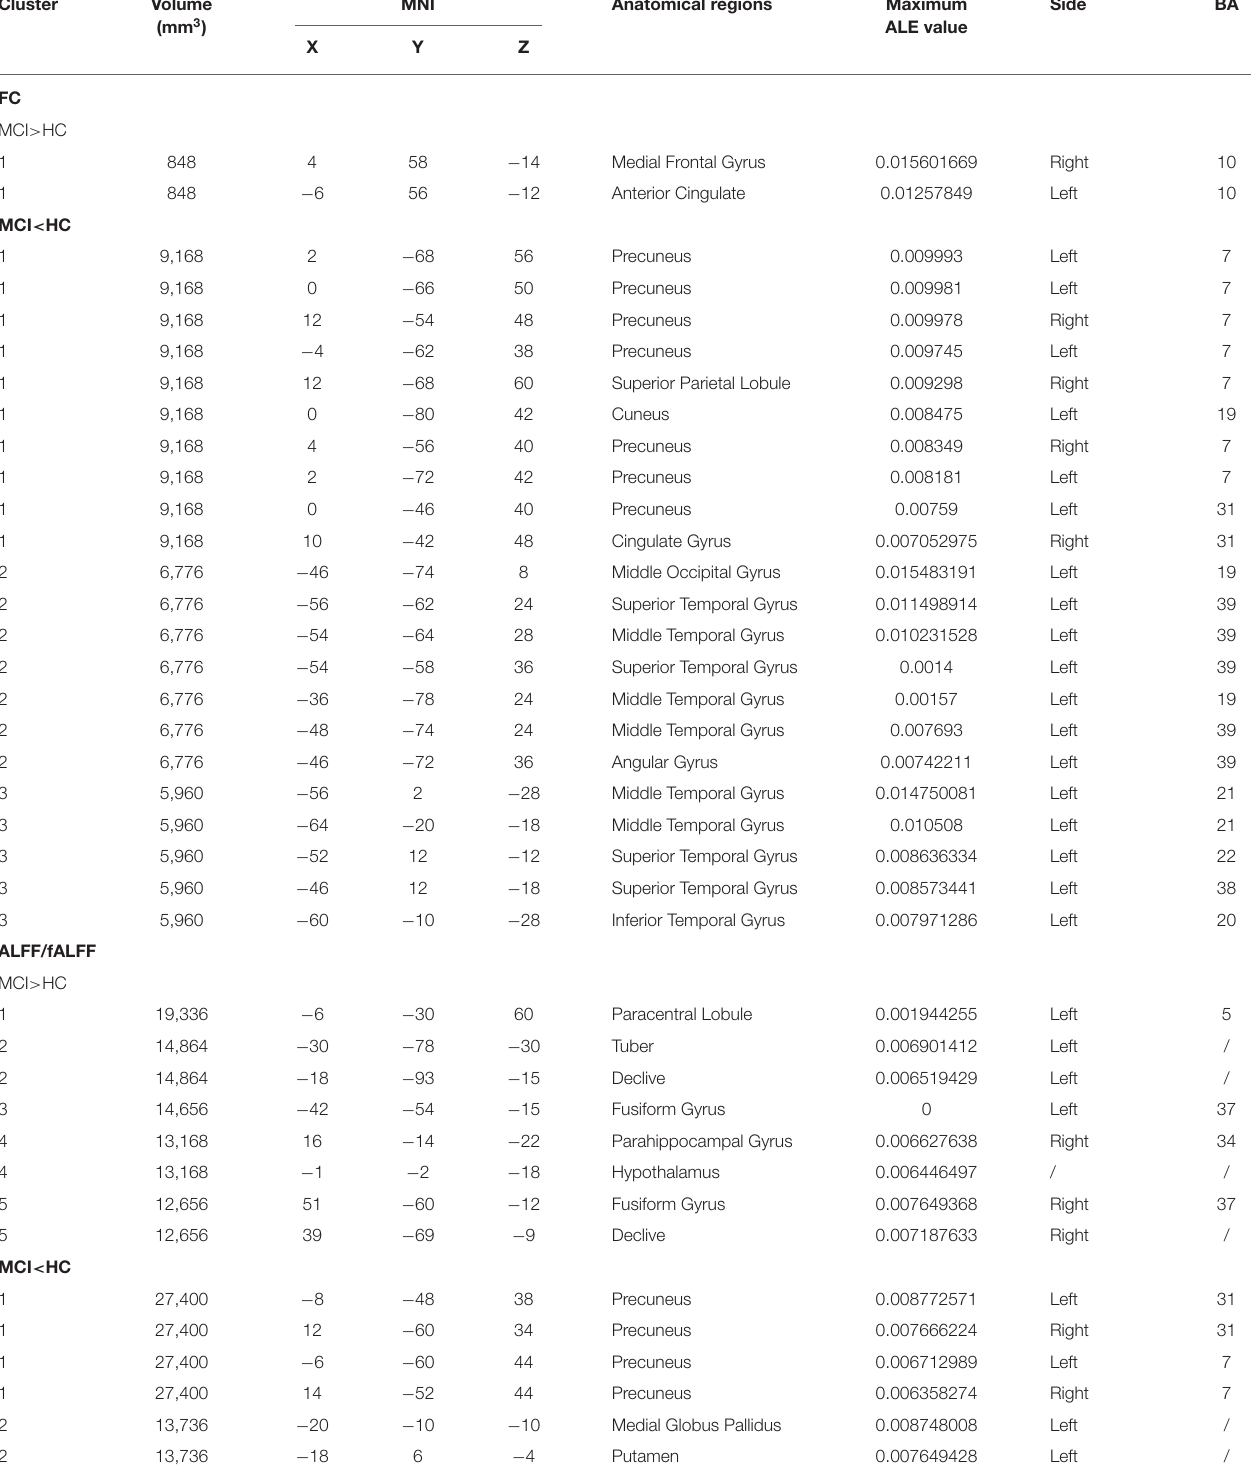
TABLE 2 | All clusters from ALE